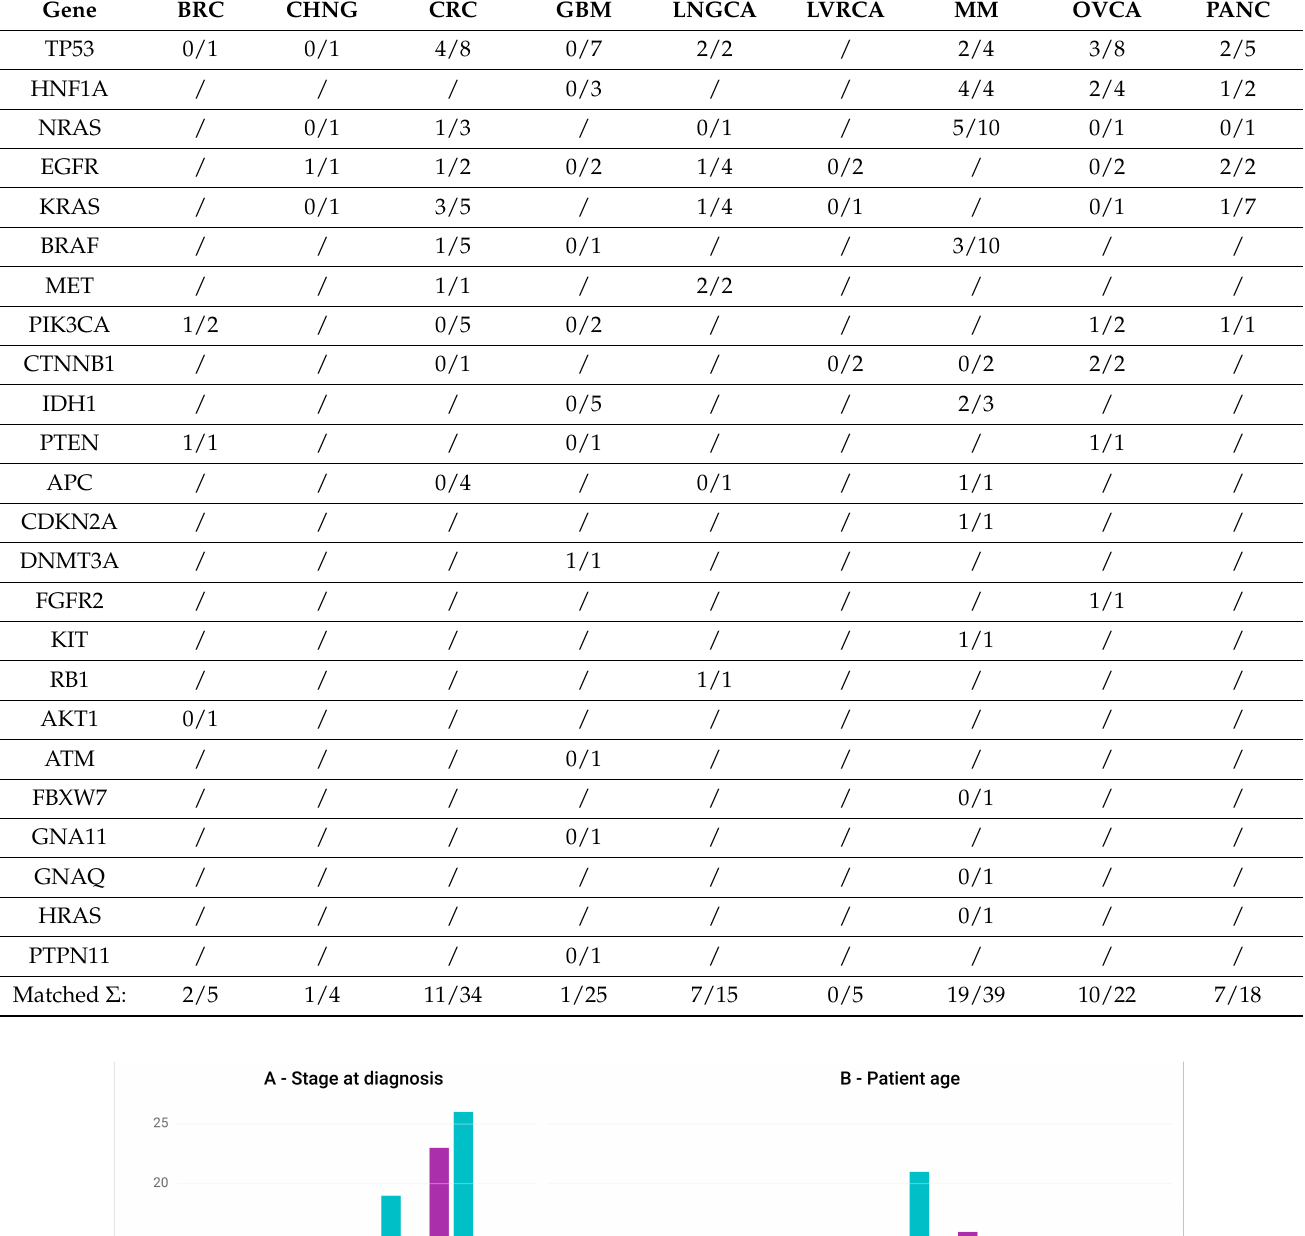
Table 1. Aggregated per-gene mutation events across different tumor types showing number of mutation events detected in both tumor DNA and plasma DNA samples versus total count of detected mutations in tumor DNA samples.